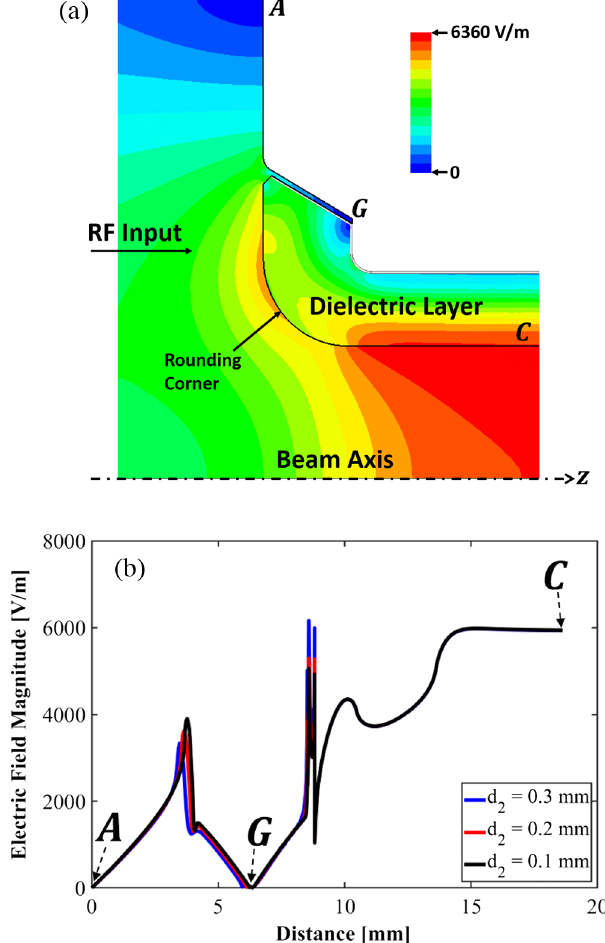
FIG. 9. (a) Electric field distribution for the dielectric matching section with a design gap, where the thin metallic coating is denoted by the white lines. (b) Electric fields magnitude along path AGC for different design gaps d 2 . Here path AGC denotes a section of lines and arcs connected by the points A , G , and C , as shown in (a), where the distance of point A is taken as 0